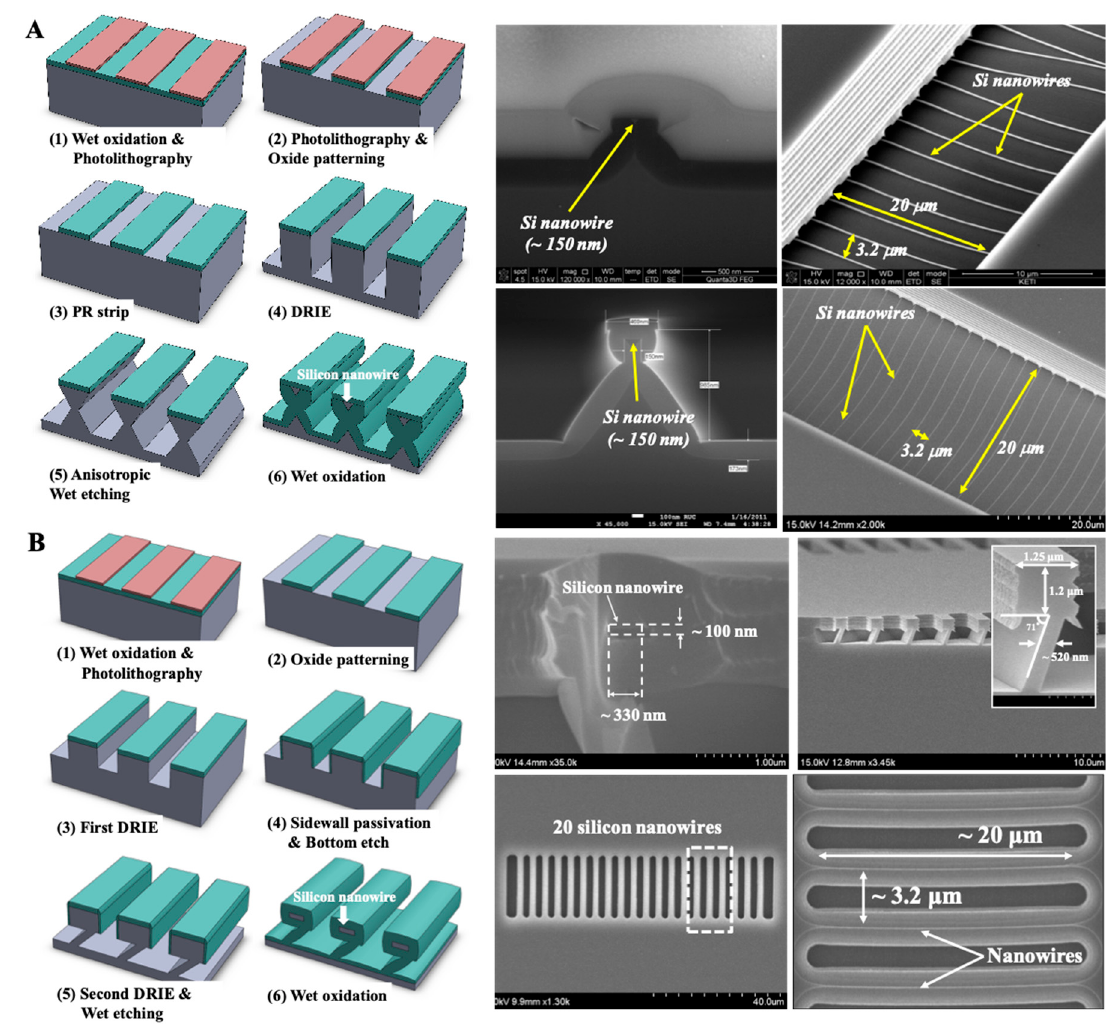
Figure 2. Top-down fabrication process and results using single-crystalline silicon (SCS) wafer. ( A ) (100)-silicon (adopted with permission from [51,52]). ( B ) (111)-silicon (adopted with permission from [53]).